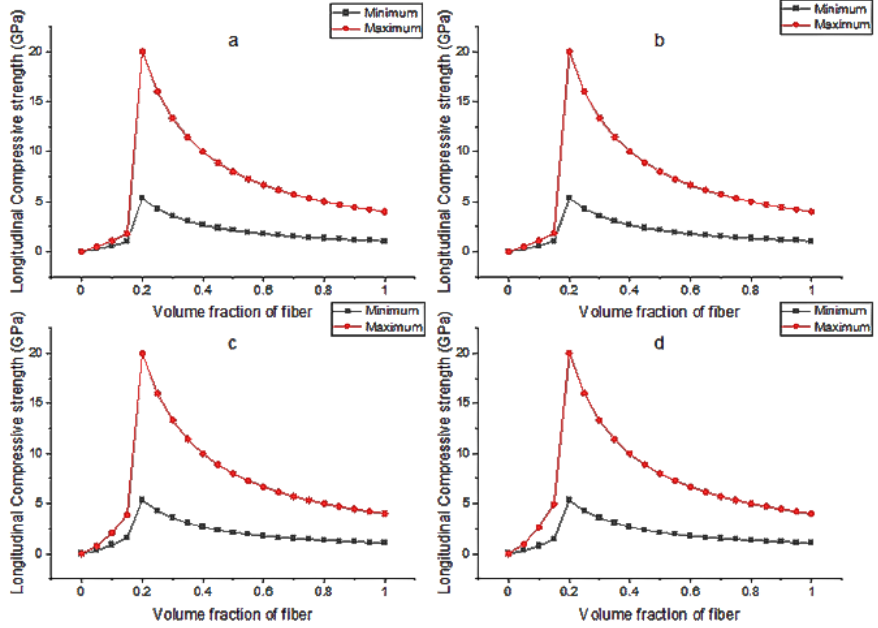
Figure A6. Depicts the variation in longitudinal compressive strength of ( a ) E-glass, ( b ) S-glass, ( c ) T300 carbon fiber and ( d ) AS carbon with volume of fiber. It can be seen that the value of longitudinal compressive strength is maximum at 20% fiber ratio and then decreases upto 100% fiber